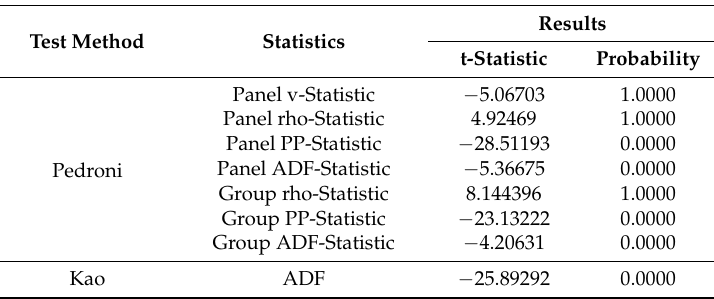
Table 3. Contegration test results.